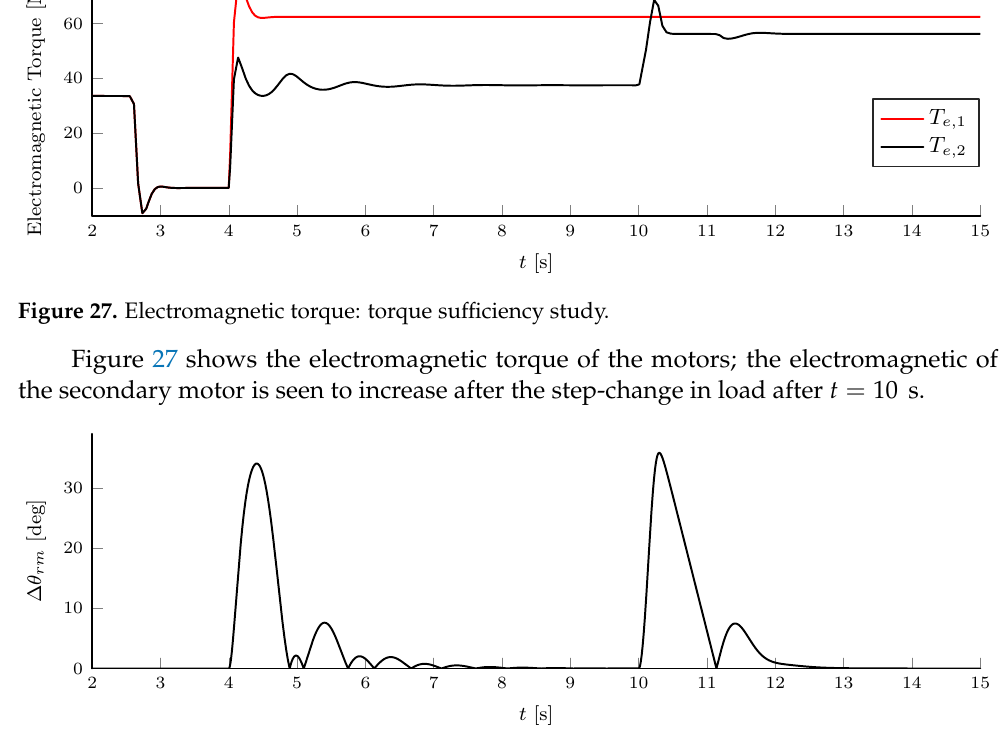
Figure 28. Normed angle difference: torque sufficiency